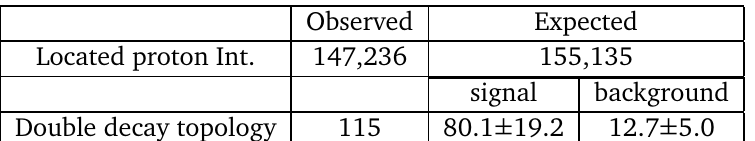
Table 1: Analysis results of a sub-sample of the pilot run